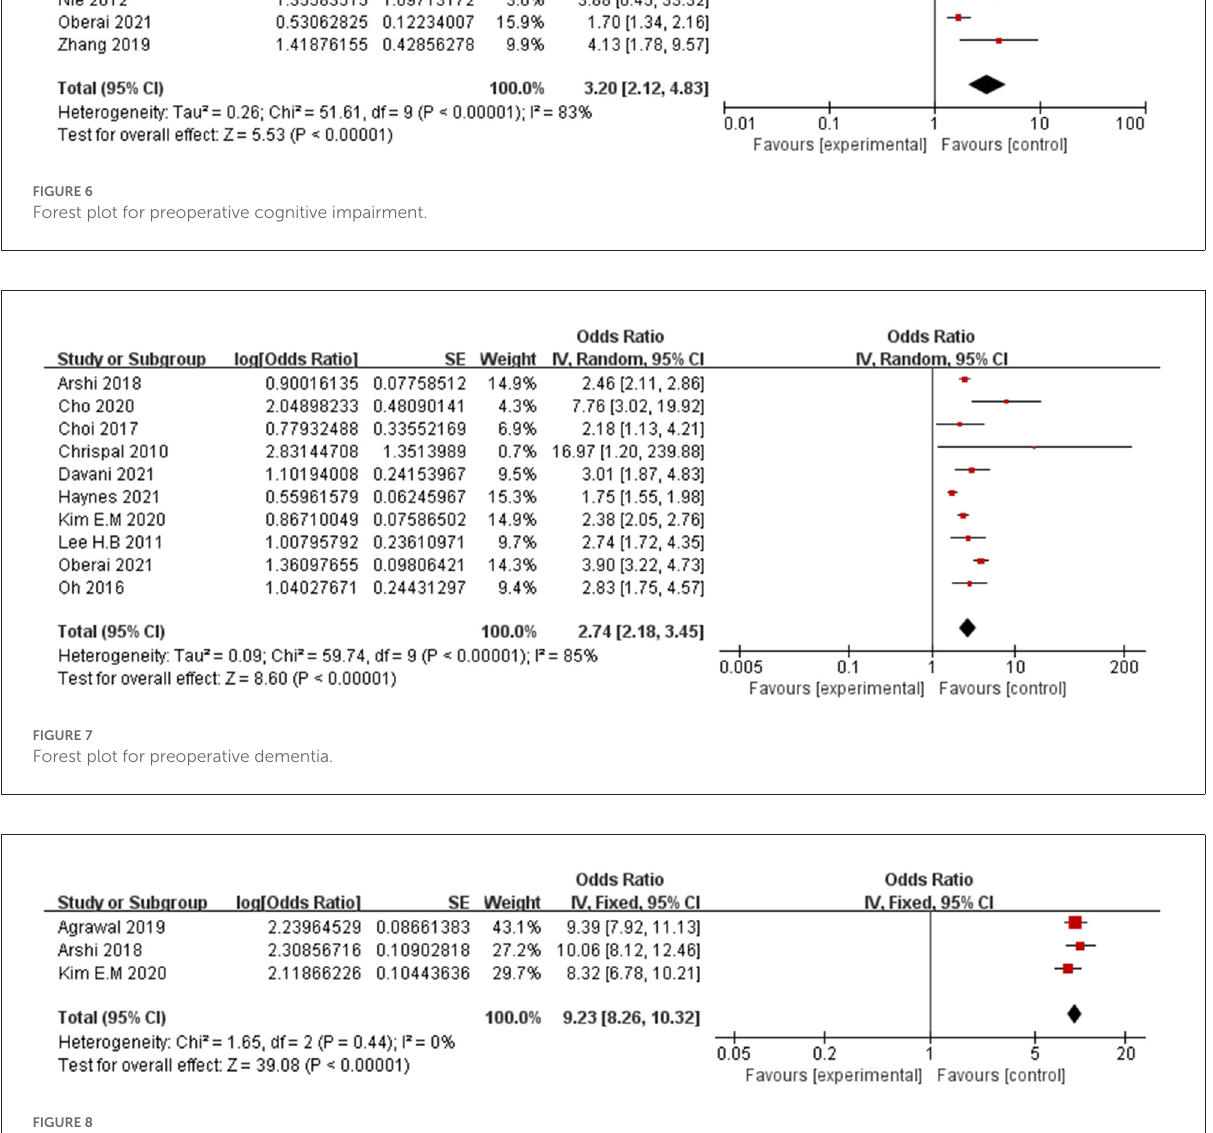
significant heterogeneity was found among these studies ( P = 0.008, I 2 = 71%). The meta-analysis of the pooled studies suggests that preoperative functional dependence is a significant risk factor for the development of POD (OR: 1.31, 95% CI 1.11– 1.56, P = 0.002, Additional File 4 in Supplementary